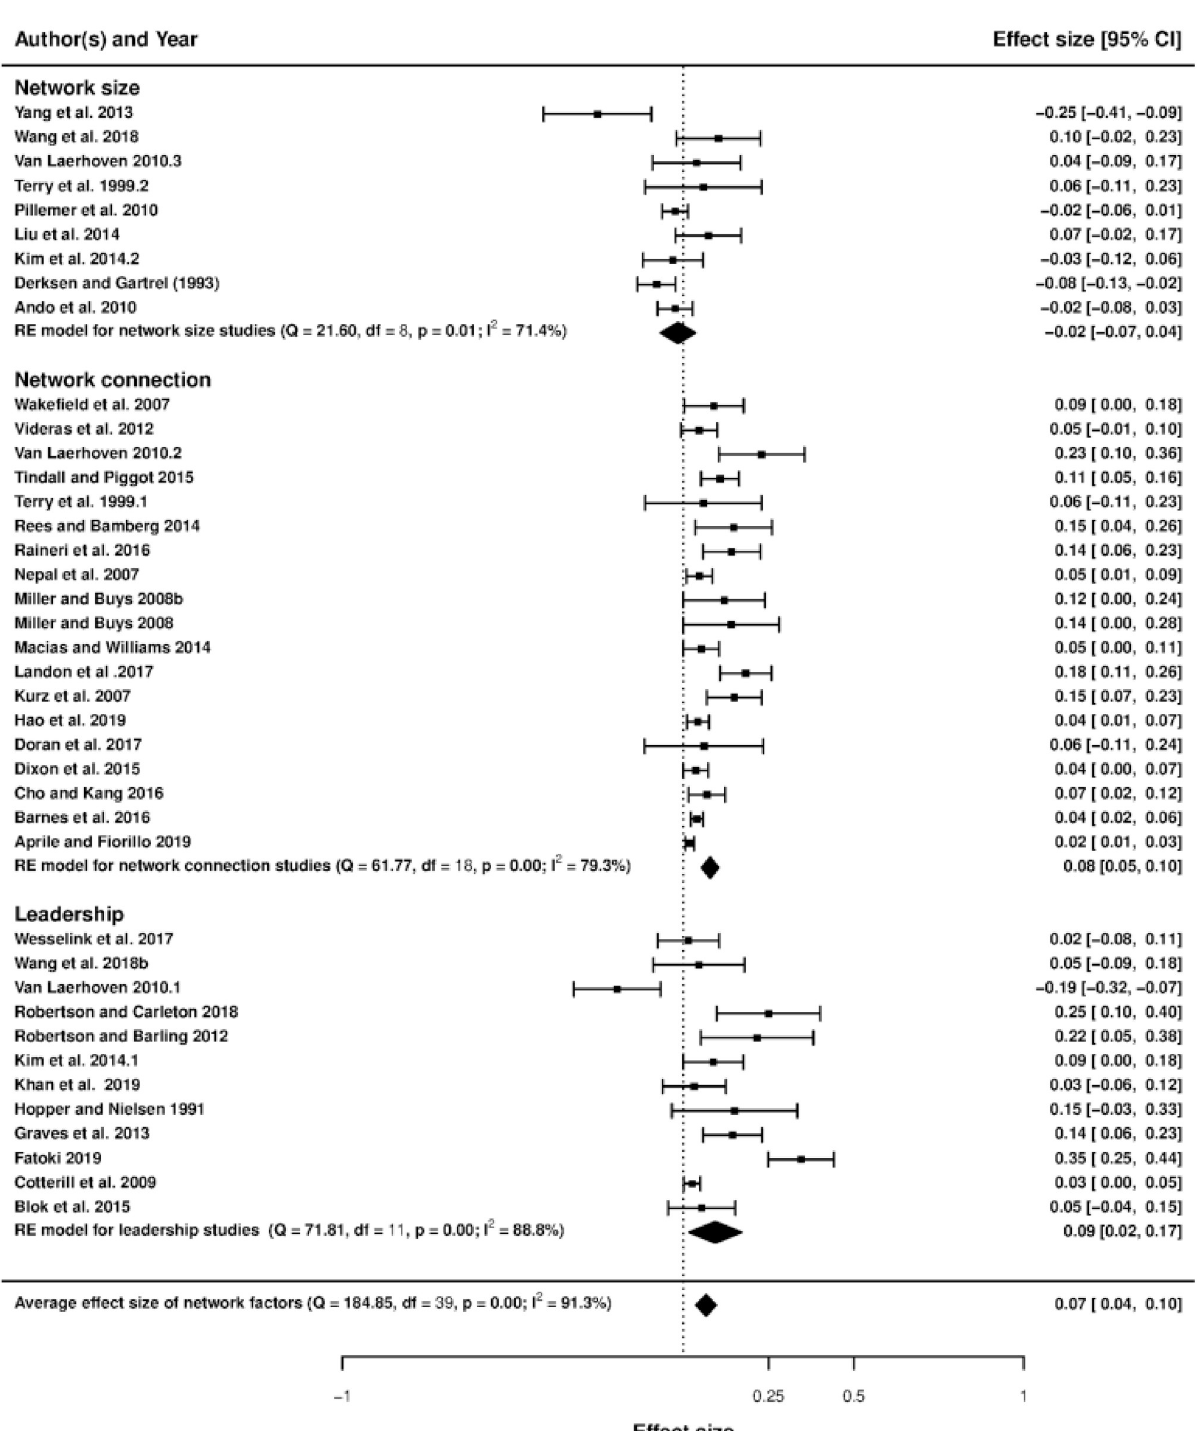
Fig 5. Forest plot of network